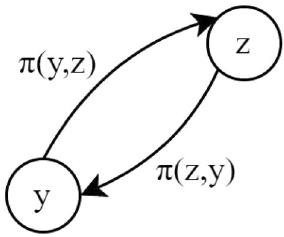
Figure 3. Valued Outranking Graph.